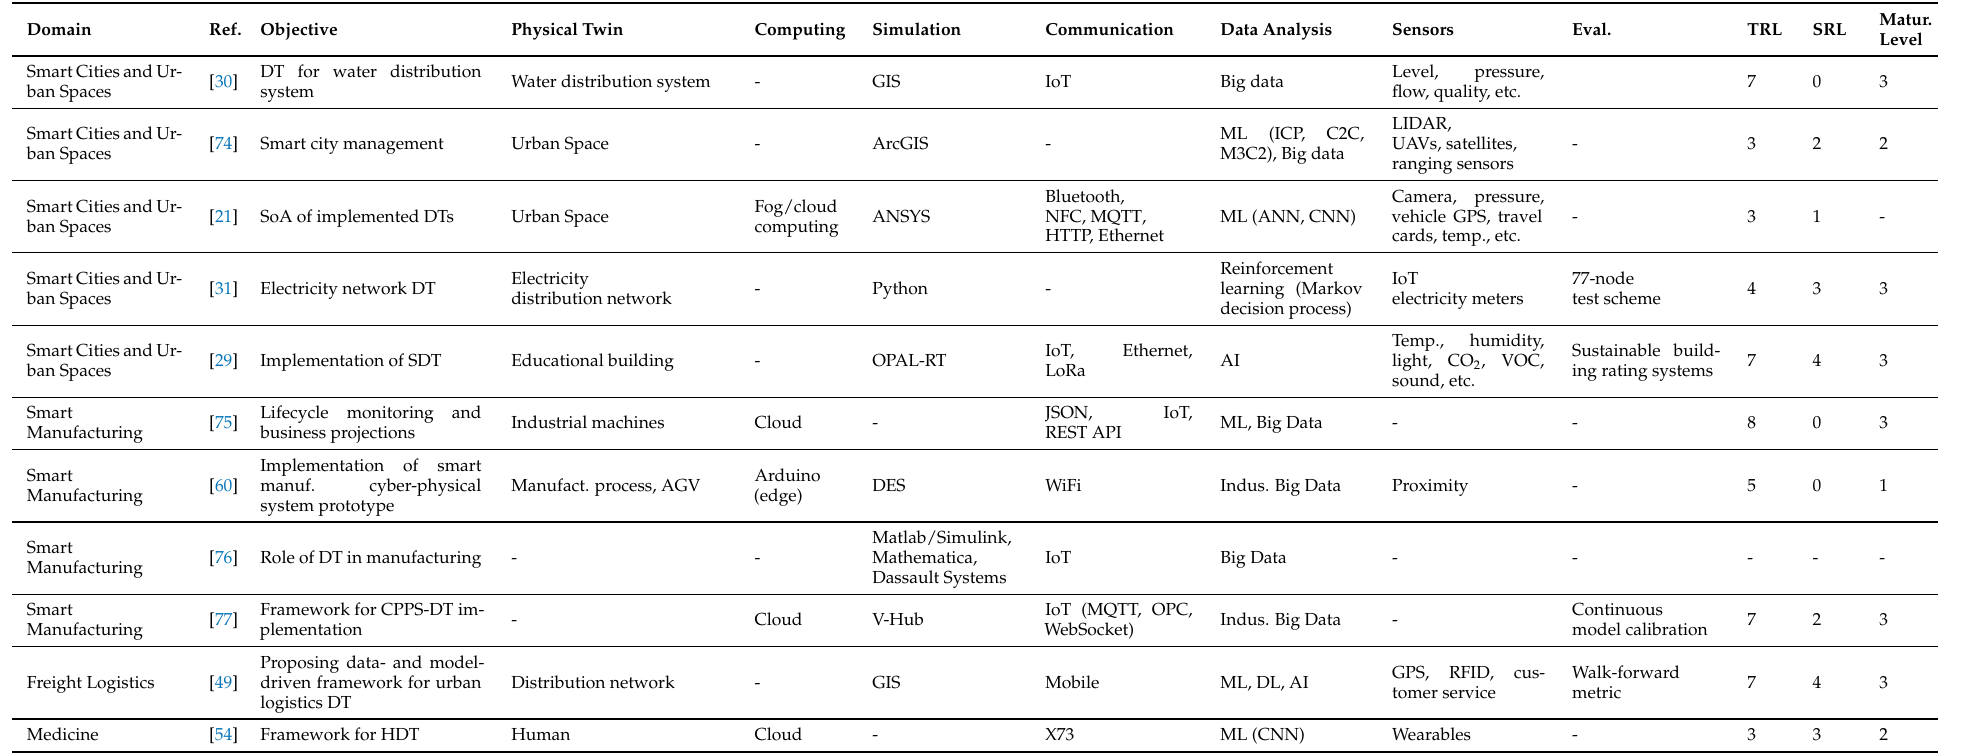
Table 2. DT application technological